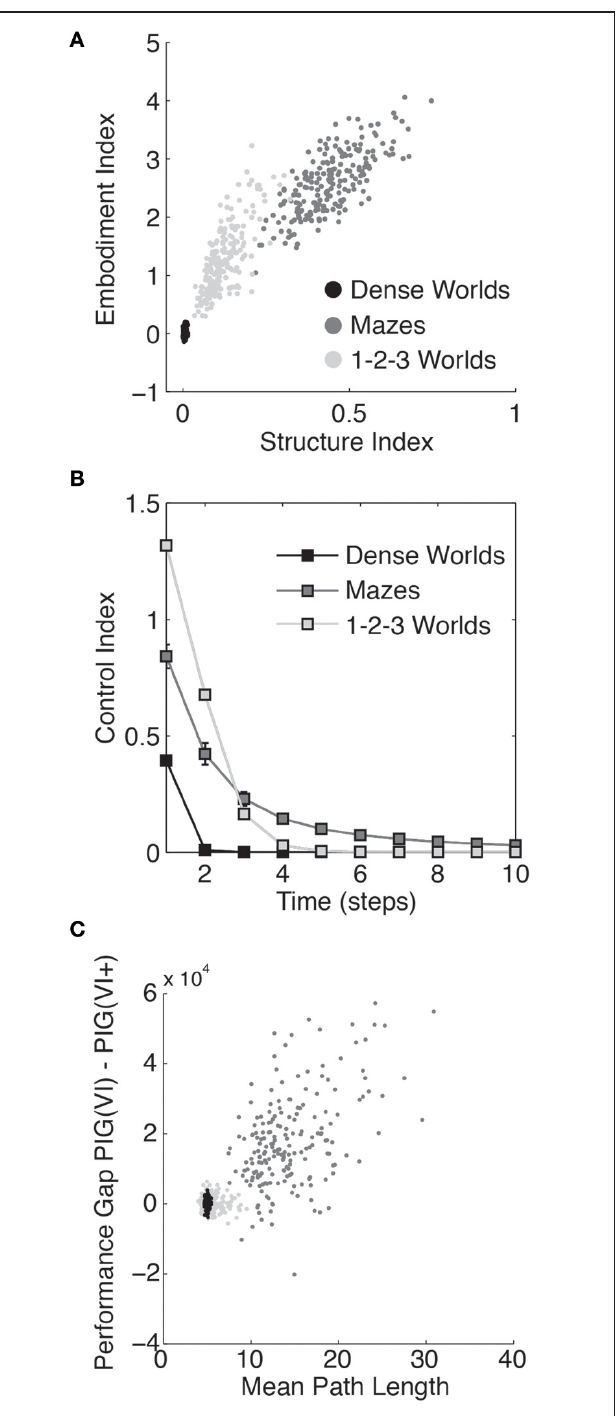
FIGURE 5 | Quantifying the structure of the worlds. (A) The embodiment index, defined in section 3.3, is plotted against the structure index for each of 200 Dense Worlds, Mazes, and 1-2-3 Worlds. (B) For the same CMCs, the average controllability is plotted as a function of the number of time steps the state lies in the future. The error bars depict standard deviations. (C) Again for the same CMCs, the learning performance gap in between PIG(VI) and PIG(VI + ) is plotted against the mean path length between any two